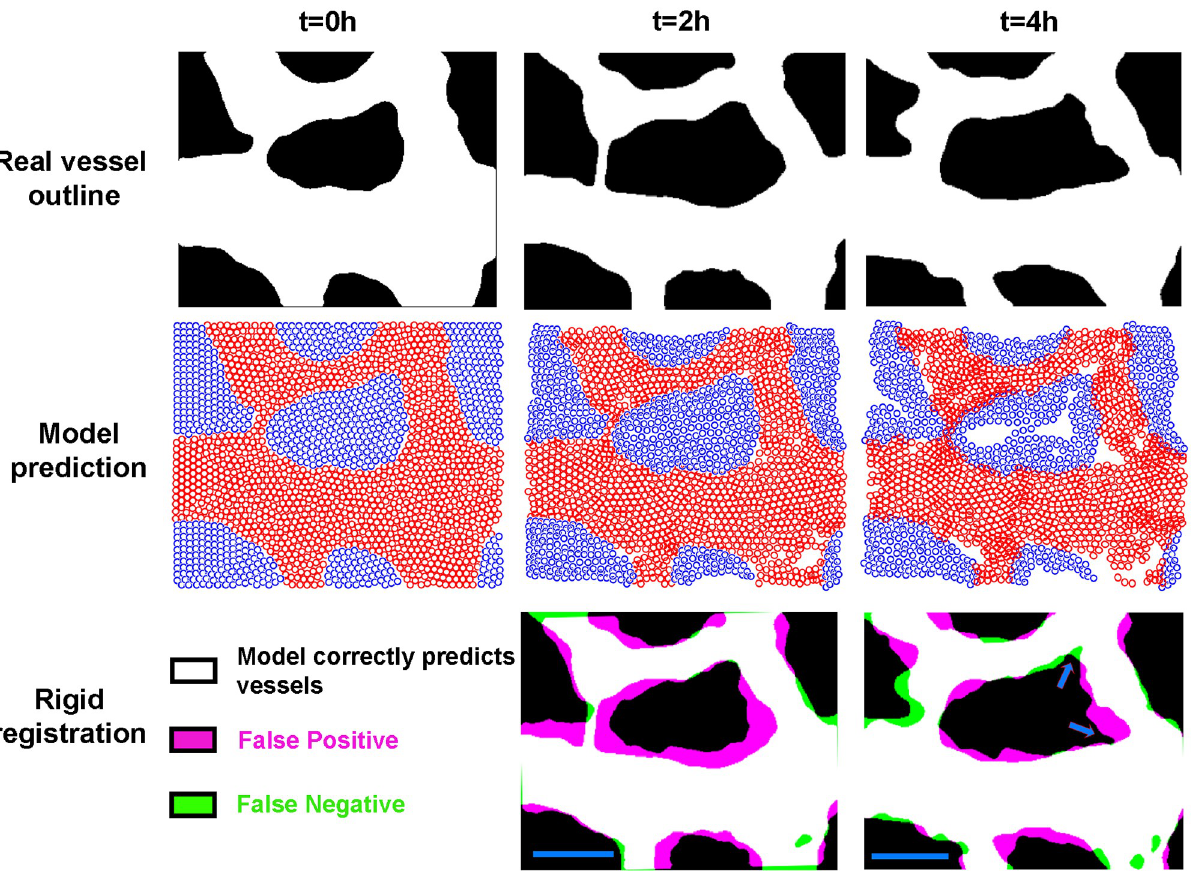
Fig 6. Model prediction for a simple vessel shape. First row shows the shape of vessels, with white as vascular and black as avascular regions, from a time-lapse of an embryonic vasculature undergoing remodelling at time zero (used as an input for the model) and after two and four hours. The second row shows how vascular (red) and avascular agents (blue) migrate and how vascular agents elongate and avascular agents expand, leading to the final position of these agents. The third row compares the real outlines with the model prediction of the vascular regions using rigid registration. To make the binary image of the model prediction, the elliptical agents were assigned a flexibility of 25%. The blue arrows show the avascular expansion. The parameters used for this model: α = 100, β = 40, z = 0, ω = 20, η = 0.1, κ = 20, β